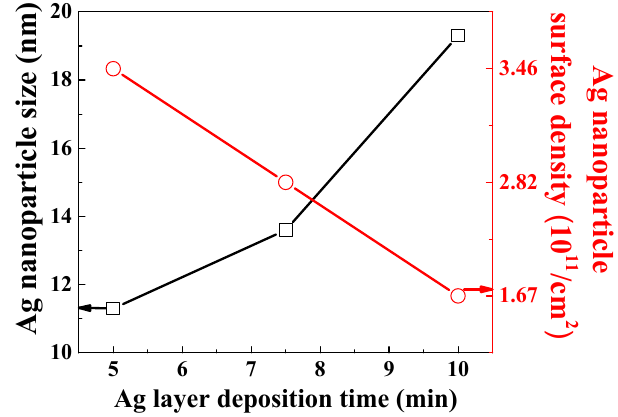
Figure 4. Ag-NPS average size ( □ ) and the surface density ( ○ ) with respect to thermal evaporation deposition time.